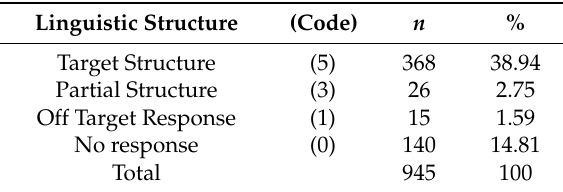
Table 5. Totals of Coded